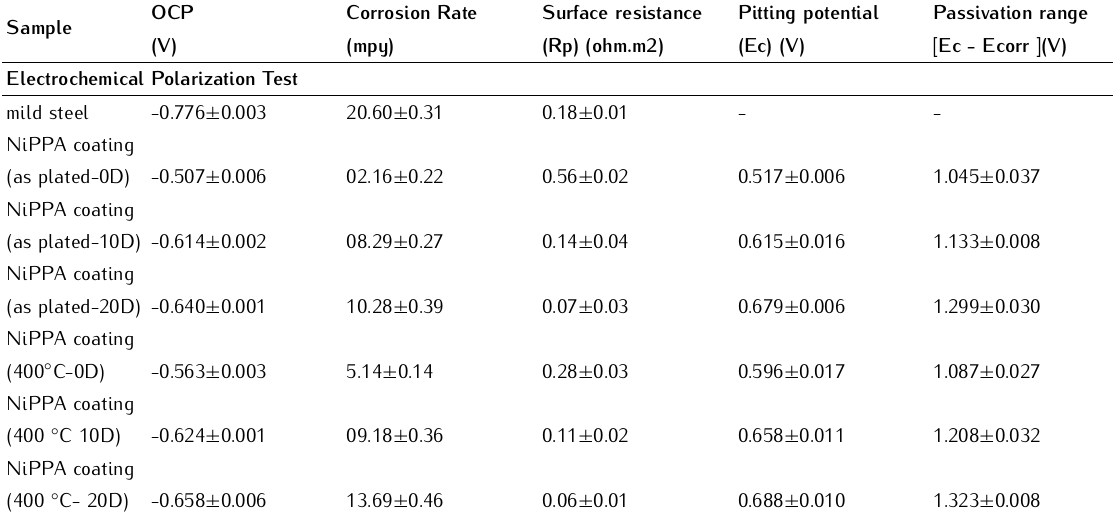
Table 5. Corrosion Parameters of ms, NiPPA coating as plated before and after exposure and Heat treated at 400 ◦ C before and after exposure for 10D and 20D. Sample